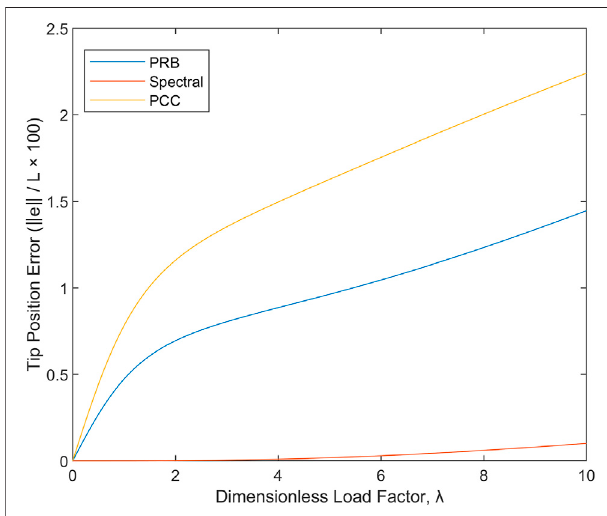
FIGURE6 | Error in reproducing the correct behavior under cantilevered loadingconditionsforthree-DOFkinematic hypothesesofthePCC,PRB,and spectral